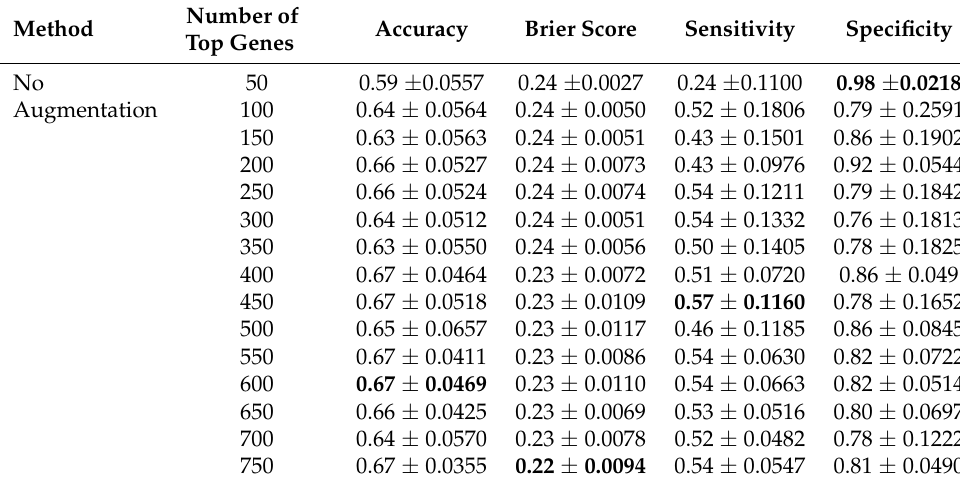
Table 3. Classification performance measures for RNA-seq data (test subsets) after training with original training data only. The table shows the 95% confidence intervals (mean ± 1.96 standard errors) for accuracy, Brier score, sensitivity and specificity, respectively. Values in bold are the best scores for the respective performance metric. Number of Accuracy Brier Score Sensitivity Method Top Genes